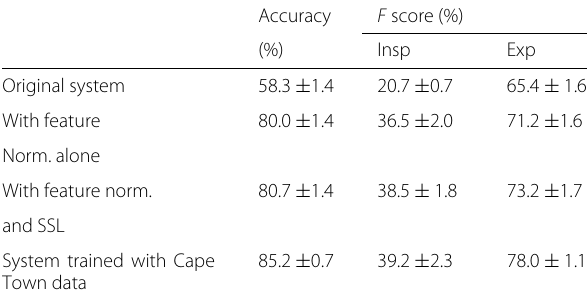
Table 5 Comparison of the performance of the original segmentation system with the adapted system on Cape Town